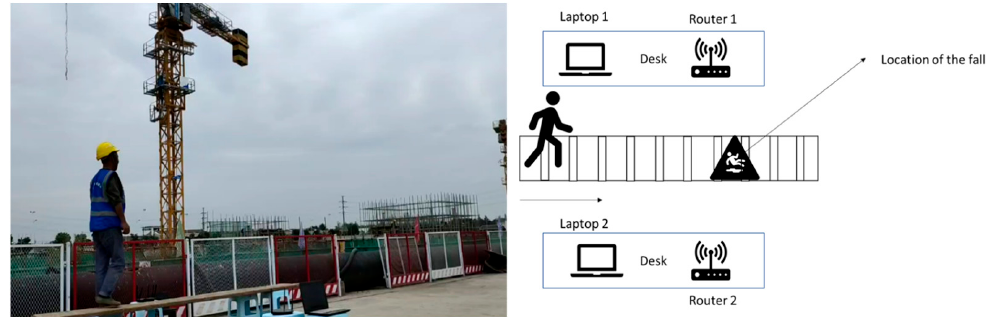
Figure 5. Experimental scenario.